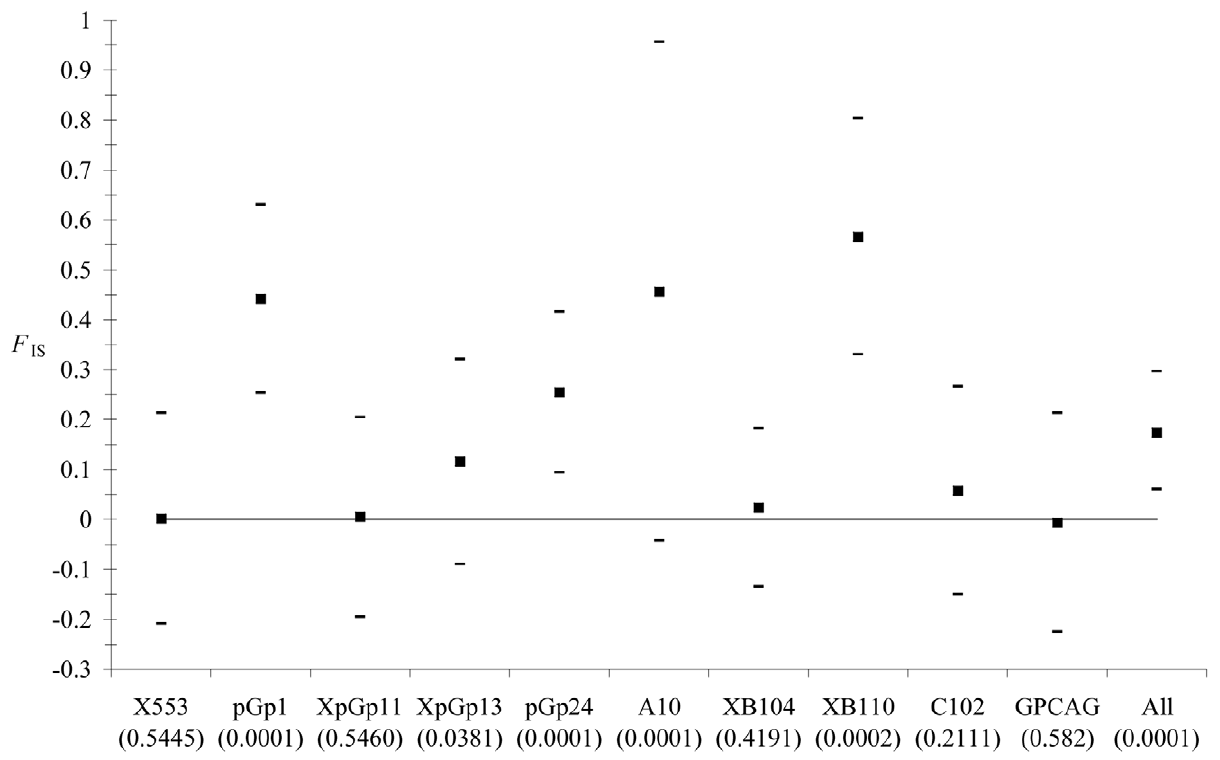
Figure 2. F IS across loci and overall loci. For each locus 95% confidence intervals (CI) were obtained by jacknives over populations. Overall loci (All), CI were obtained by bootstrap over loci. Deviations from panmixia are given as corresponding P -values between brackets.